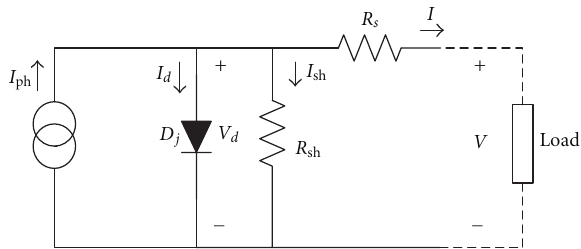
Figure 1: Proton exchange membrane fuel cell power generation diagram.